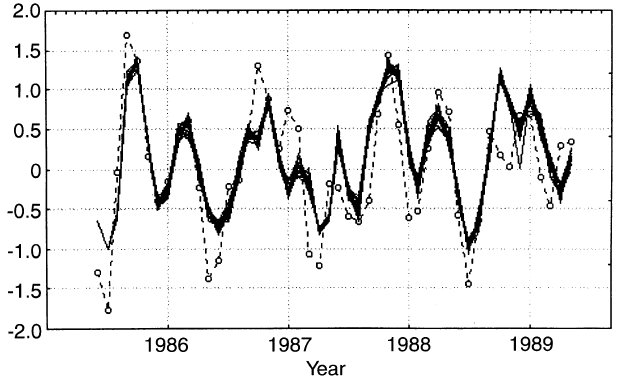
Fig. 7. Graphical representation of ensemble forecast: dashed line indicates the behaviour of observed data, solid lines indicate the behaviour of